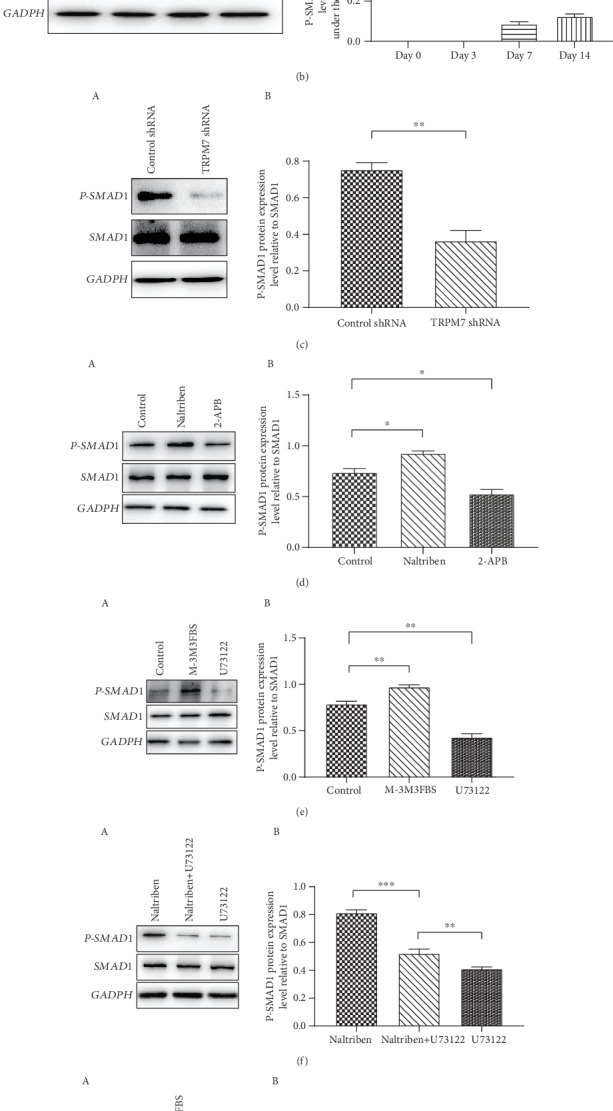
The analysis of SMAD1 activity under inhibiting or activating TRPM7 and inhibiting or activating PLC (HSPG2). (a) (A) The activity of SMAD1 protein in cells induced with osteogenic medium for 0, 3, 7, and 14 days. (B) The relative activity of SMAD1 protein was quantified and plotted. (b) (A) The expression of P-SMAD1 protein in cells noninduced for 0, 3, 7, and 14 days. (B) Relative expression levels of P-SMAD1 protein were quantified and plotted. (c) (A) Western blot analysis of SMAD1 protein in cells induced with osteogenic medium or osteogenic medium plus shRNA-mediated knockdown of TRPM7 induced for 14 days. (B) The relative activity of SMAD1 protein was quantified and plotted. (d) (A) Western blot analysis of SMAD1 protein in cells induced with osteogenic medium or osteogenic medium supplemented with Naltriben or 2-APB induced for 14 days. (B) The relative activity of SMAD1 protein was quantified and plotted. (e) (A) Western blot analysis of SMAD1 protein in cells induced with osteogenic medium or osteogenic medium supplemented with M-3M3FBS or U73122 induced for 14 days. (B) The relative activity of SMAD1 protein was quantified and plotted. (f) (A) Western blot analysis of SMAD1 protein in cells induced with osteogenic medium supplemented with 20 μM Naltriben or 20 μM Naltriben plus 1 μM U73122 or 1 μM/mL U73122 induced for 14 days. (B) The relative activity of SMAD1 protein was quantified and plotted. (g) (A) Western blot analysis of SMAD1 protein in cells induced with osteogenic medium supplemented with 20 μM M-3M3FBS or 50 μM 2-APB plus 20 μM M-3M3FBS or 50 μM 2-APB induced for 14 days. (B) The relative activity of SMAD1 protein was quantified and plotted. ∗P < 0.05, ∗∗P < 0.01, and ∗∗∗P < 0.0001.